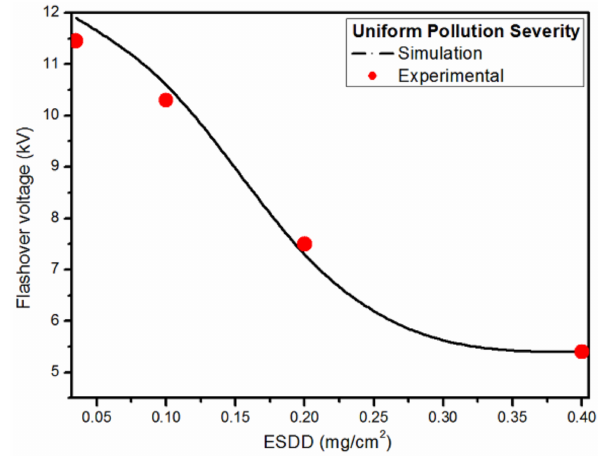
Figure 17. Flashover voltage at different NSDD values for a uniform pollution